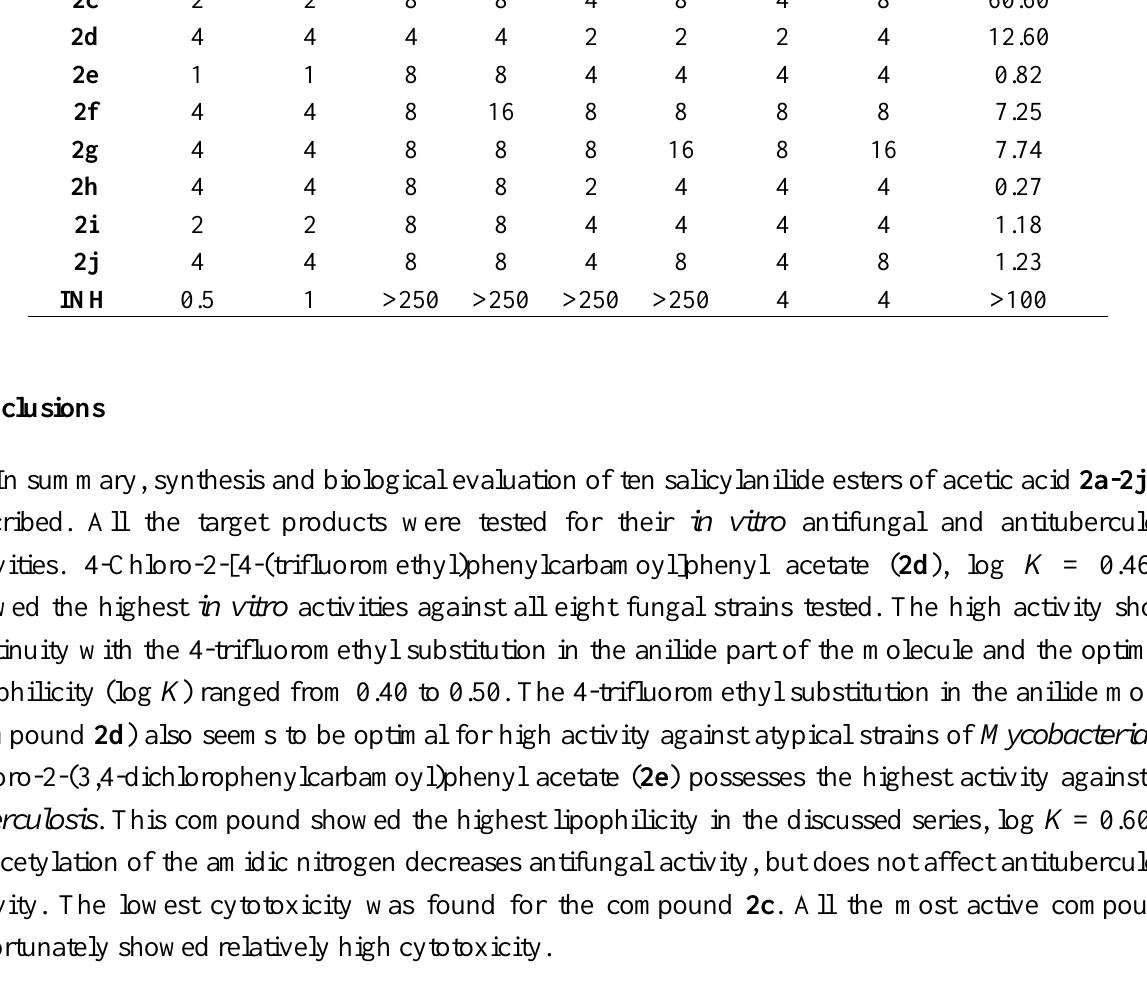
Table 4. In vitro antimycobacterial activity expressed as MIC [µmol/L] against M. tuberculosis and atypical strains M. kansasii and M. avium in comparison with standard isoniazide as well as cytotoxicity of the compounds on HCT-8 cells expressed as IC